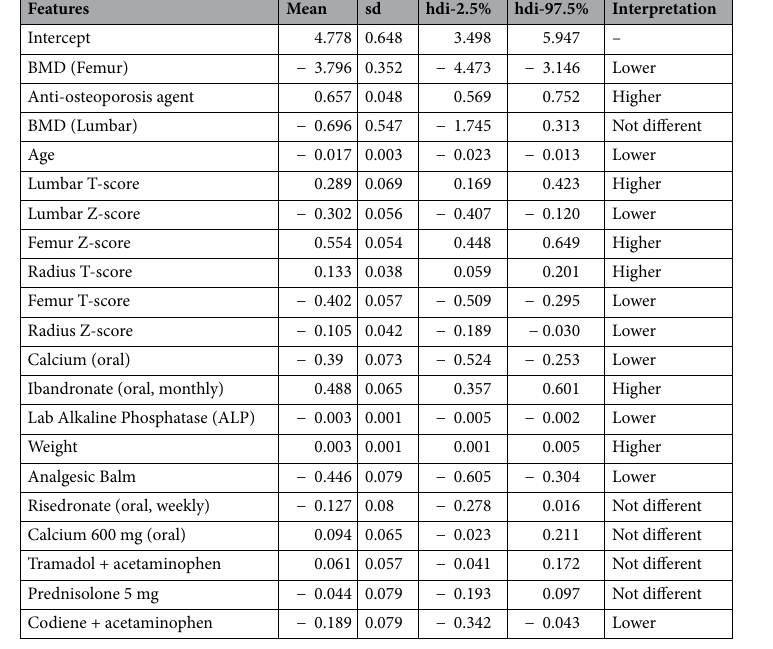
Table 4. Analysis of Bayesian logistic regression of the top 20th